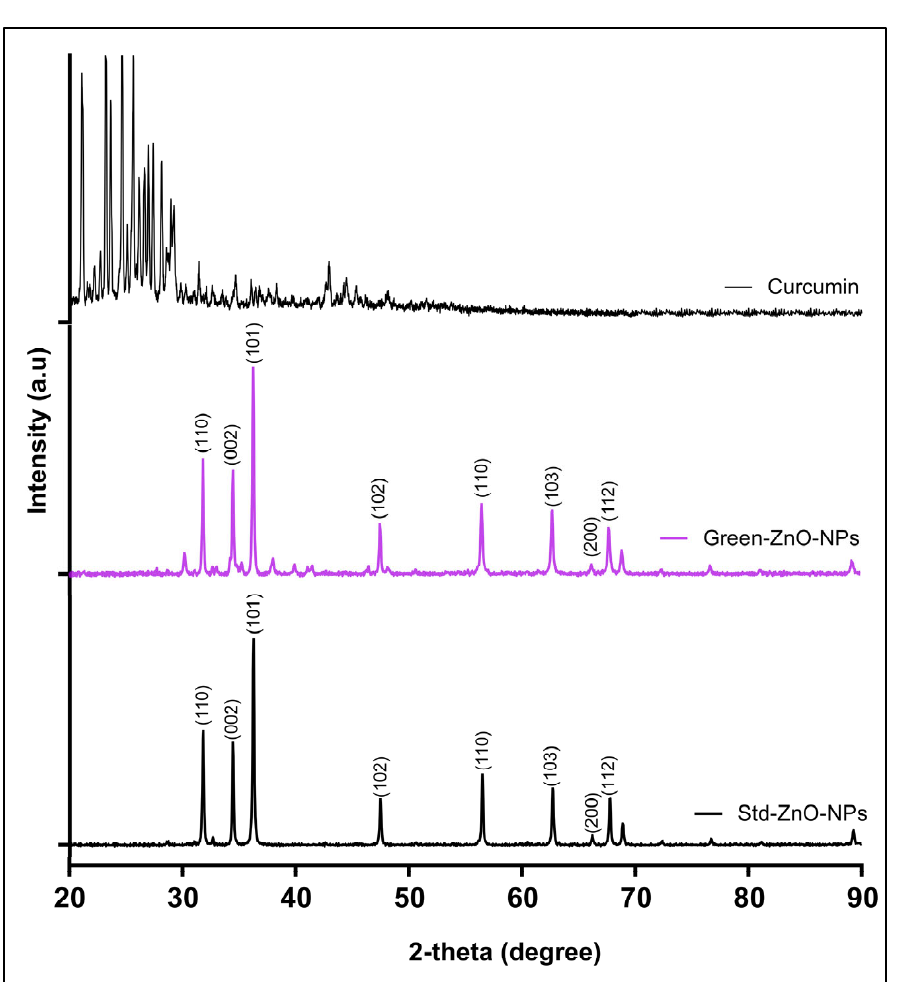
Figure 4. X ‐ ray powder diffraction patterns of curcumin ( up ), Green ‐ ZnO ‐ NPs ( middle ) and Std ‐ Figure 4. X-ray powder diffraction patterns of curcumin ( up ), Green-ZnO-NPs ( middle ) and Std- ZnO ‐ NPs ( down ). ZnO-NPs ( down